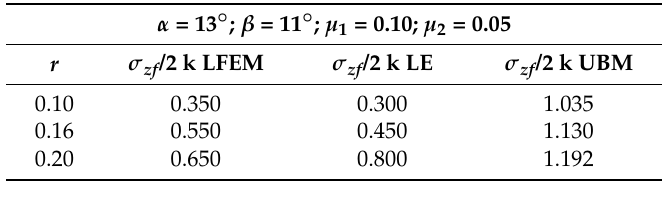
Figure 10. Literature experimental (LE) and theoretical (T) effective flow stress-strain curves for the Ni-Ti shape-memory alloy. Table 6. σ zf /2 k values. Column 1 by literature FEM simulations (LFEM), column 2 by literature experiments (LE), and column 3 by upper bound method (UBM).